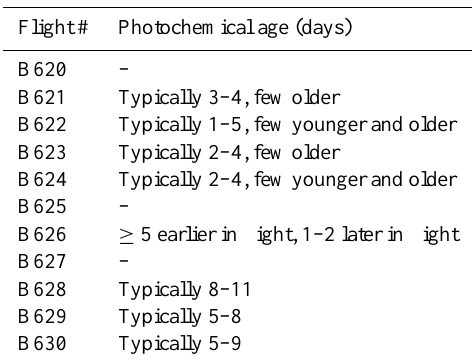
Table 6. Range of photochemical ages of air masses, identified as being of pyrogenic origin using CO, CH 3 CN and HCN concentra- tions, intercepted during non-transit BORTAS-B flights, 15 July–31 July